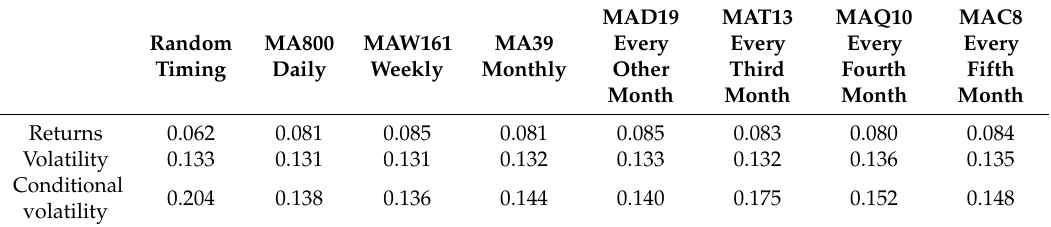
Table 4. The 800 trading-day rolling window, average annualized returns, volatilities, and conditional volatilities in DJIA index, 4 January 1988 to 31 December 2017.